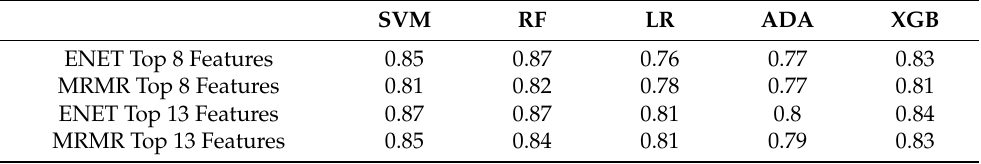
Table 6. Classification results for top eight and top 13 features of ENET and MRMR for all classifiers.